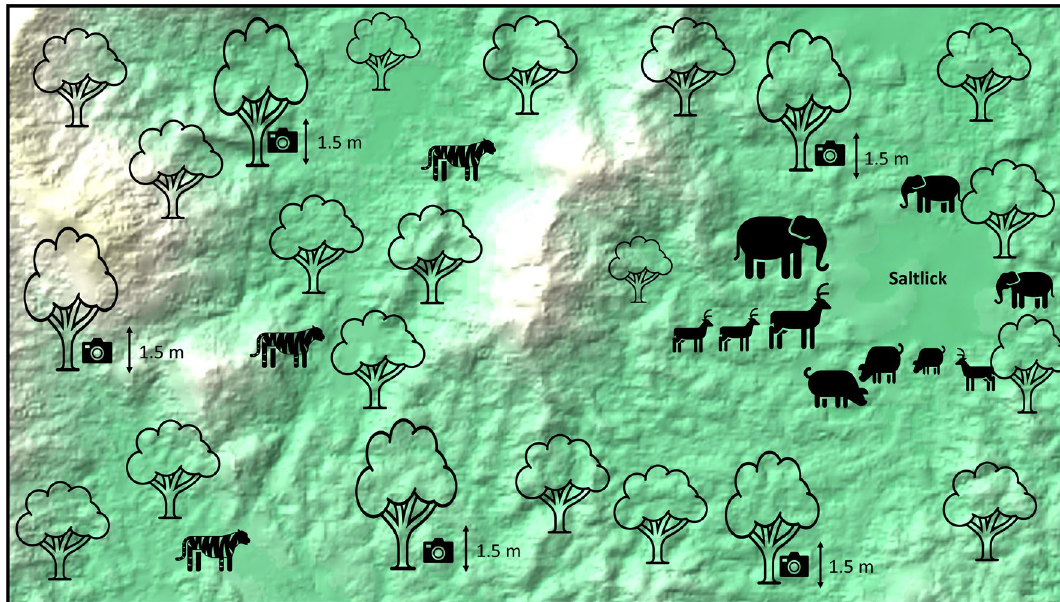
Figure 2. The placement of cameras around a natural salt licks in the Royal Belum Rainforest. Map details: The background featuring a DEM-based image is from the ArcGIS software application (https:// www. esri. com/ en- us/ arcgis/ produ cts/ arcgis- deskt op/ overv iew) with GPS reference coordinate; Latitude: 5°42 ′ 37 ″ N; Longitude: 101°31 ′ 56 ″